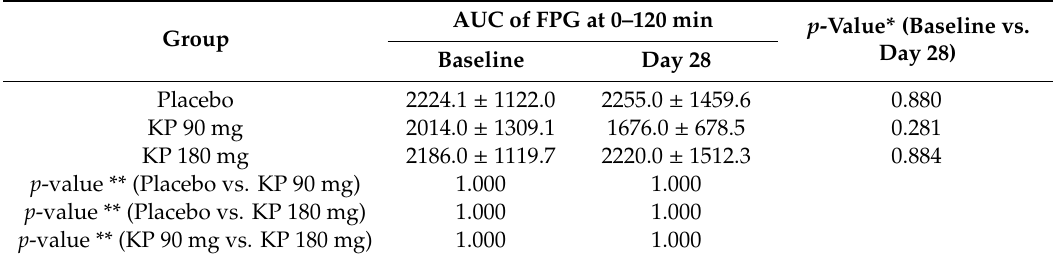
Table 3. Blood glucose levels of volunteers after glucose loading at 28 days of the treatment. FPG (mg / dL, mean ± SD) Group 0 min 30 min 60 min 120 min Placebo ( n = 15) 86.7 ± 6.9 126.9 ± 25.4 122.0 ± 41.3 79.5 ± 15.2 p -value * - < 0.001 0.004 0.088 KP 90 mg ( n = 15) 87.5 ± 6.1 120.6 ± 13.7 115.1 ± 31.7 91.3 ± 19.7 p -value * - < 0.001 0.005 0.502 p -value ** 0.949 0.588 0.549 0.312 KP 180 mg ( n = 14) 89.2 ± 10.2 142.5 ± 43.9 129.4 ± 61.9 94.2 ± 36.5 - < 0.001 0.018 0.542 p -value ** 0.833 0.186 0.533 0.214 p -value *** 0.882 0.064 0.226 0.802